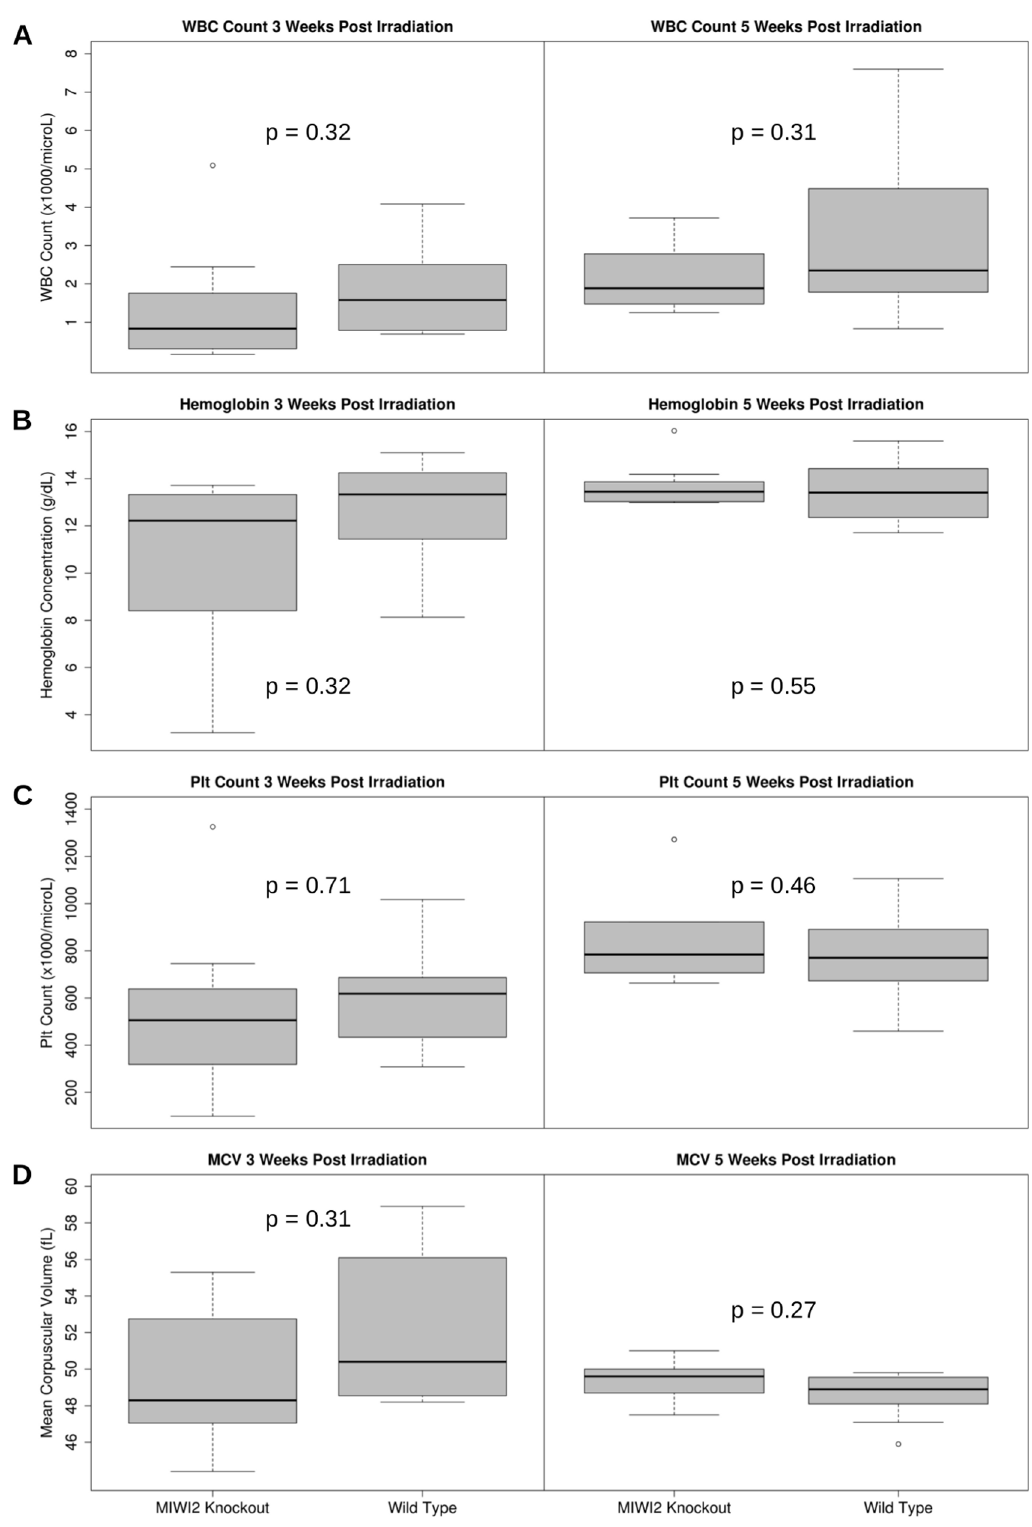
Figure 4. The effects of sublethal irradiation on blood cell indices. C57BL/6J mice were mated with mice harboring a heterozygous knockout of MIWI2. Mice were subjected to a sublethal dose of irradiation (500 cGy). Blood indices from homozygous knockout progeny (labeled ‘‘MIWI2 Knockout’’) are compared with wild type progeny at 3 weeks and 5 weeks post irradiation. The blood cell indices include [A] white blood cell count, [B] hemoglobin concentration, [C] platelet count, and [D] mean corpuscular volume. P-values indicate the comparison between wild type and knockout mice at the given time point.